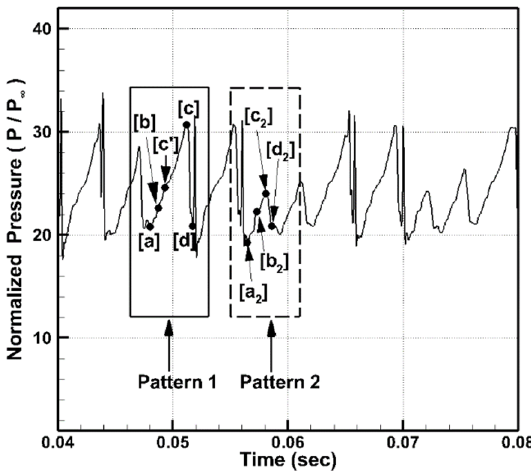
Figure 5. Time history of normalized pressure at x/h = 12.21 with a flap angle of